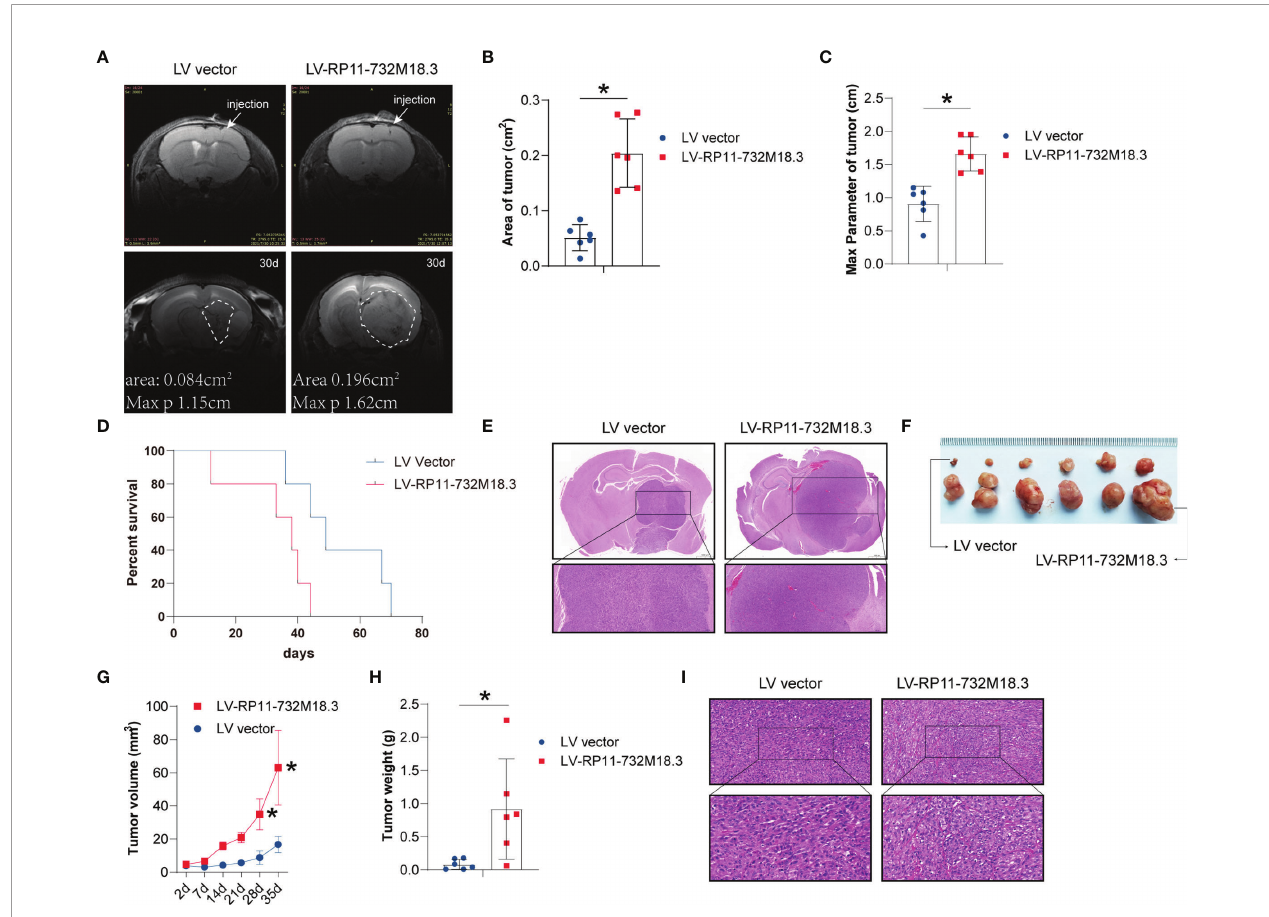
FIGURE 1 | lncRNA RP11-732M18.3 promotes tumor growth in vivo . (A) Nude mice were implanted intracranially with U87MG cells stably overexpressing lncRNA RP11-732 M18.3. Representative T2-weighted images of the mouse brain were obtained using a small animal MRI system (PharmaScan 70/16 US; Bruker, Billerica, MA, USA) (n = 10 animals in each group). (B) MRI showing larger areas of tumor in the group overexpressing lncRNA RP11-732 M18.3 (n = 6 animals in each group, * p < 0.05). (C) The max parameter for tumor increases in the group overexpressing lncRNA RP11-732 M18.3. n = 6 animals in each group * p < 0.05. (D) Overexpression of lncRNA RP11-732 M18.3 reduces survival time in the intracranial orthotopic glioma model. n = 5 animals in each group (* p < 0.05). (E) Hematoxylin and eosin (H&E) staining of brain from each mouse group. (F, G) Overexpression of lncRNA-RP11-732M18.3 promotes tumor growth in a xenograft nude mouse model. (F) Representative images of tumors. (G) Tumor growth curves (n = 6 animals. * p < 0.05). (H) Overexpression of lncRNA-RP11-732M18.3 increases the tumor weight in a xenograft nude mouse model (n = 6 animals * p < 0.05). (I) H&E staining of a xenograft tumor from each mouse